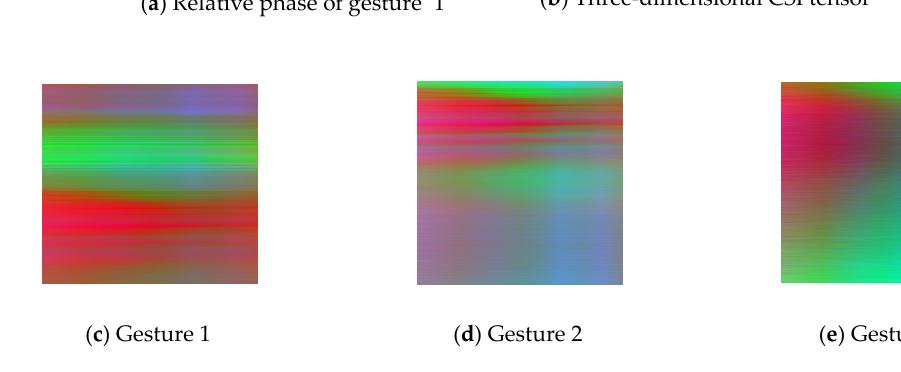
Figure 4. Image Construction.